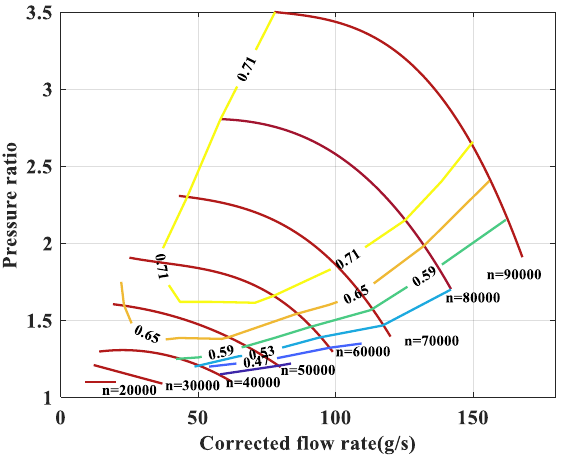
Figure 7. Air compressor performance curves.